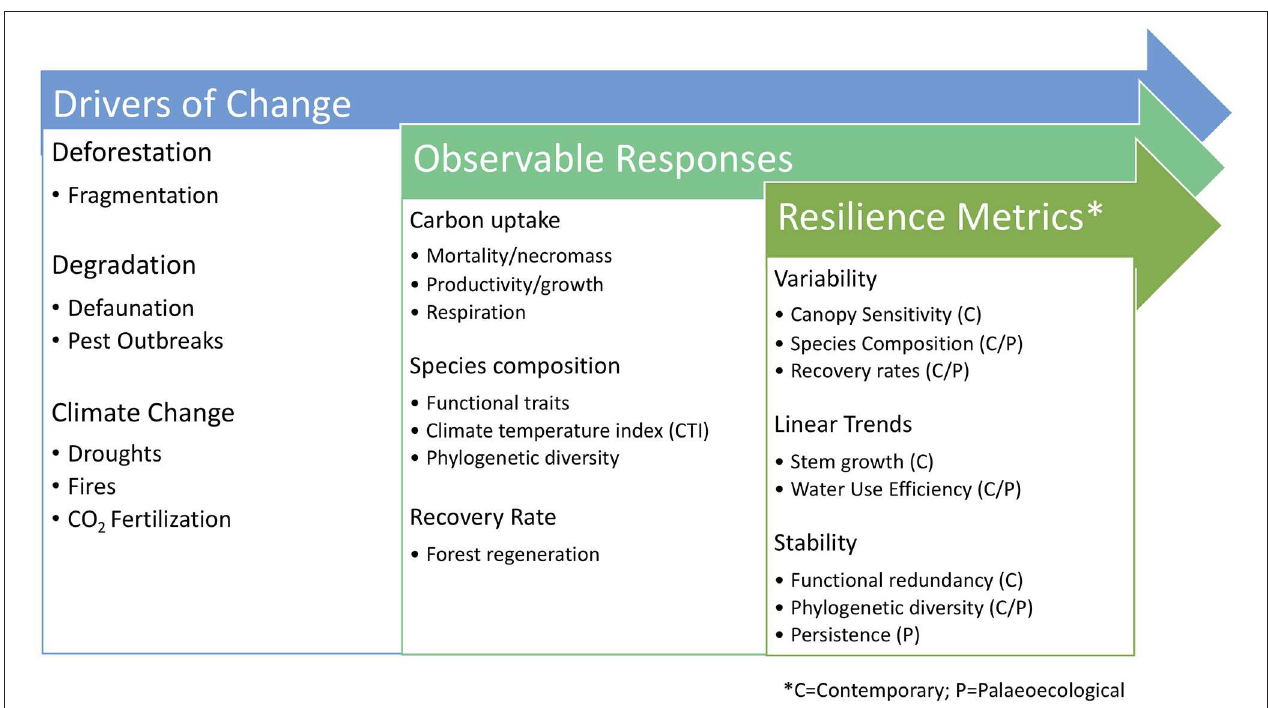
FIGURE 4 | Summary figure of key drivers of change to forests, observable responses, and the existing contemporary and paleoecological metrics to assess the resilience of forest ecosystems to these drivers of change.